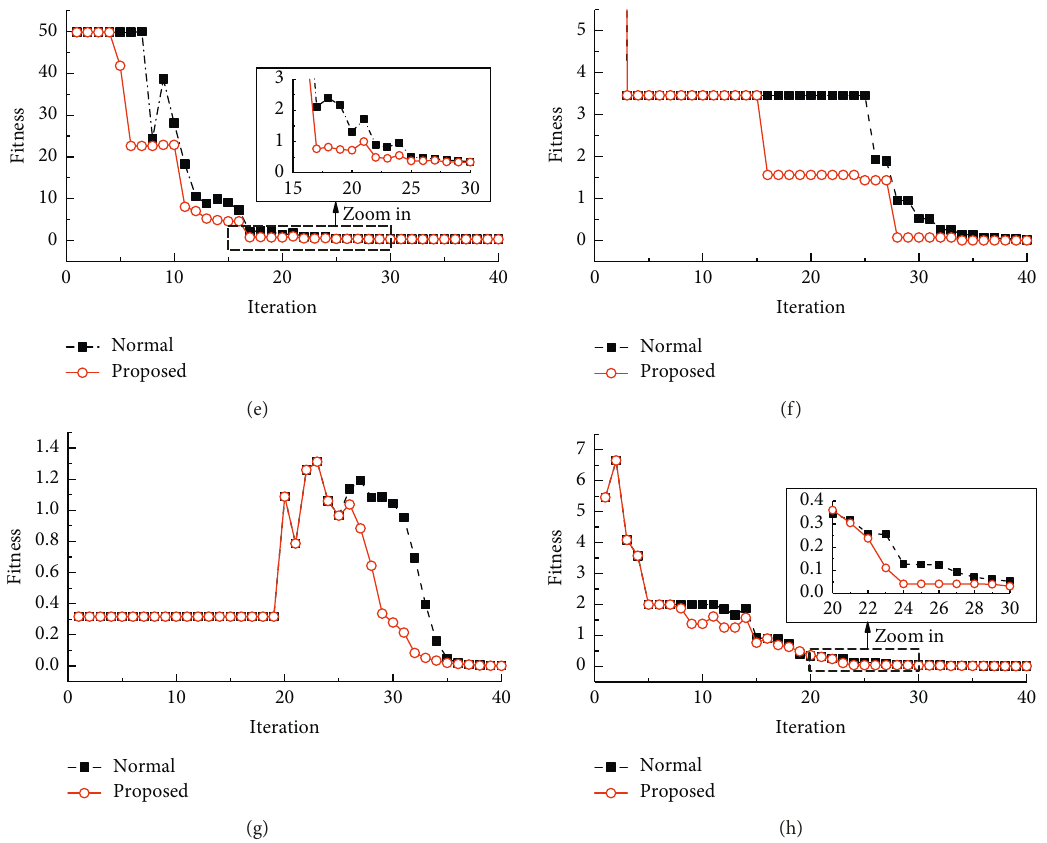
Figure 4: Representations of some common weather symbols. (a) Sphere. (b) Rosenbrock. (c) Schwefel. (d) Quadratic. (e) Penalized. (f) Rastrigin. (g) Griewank. (h) Ackley.